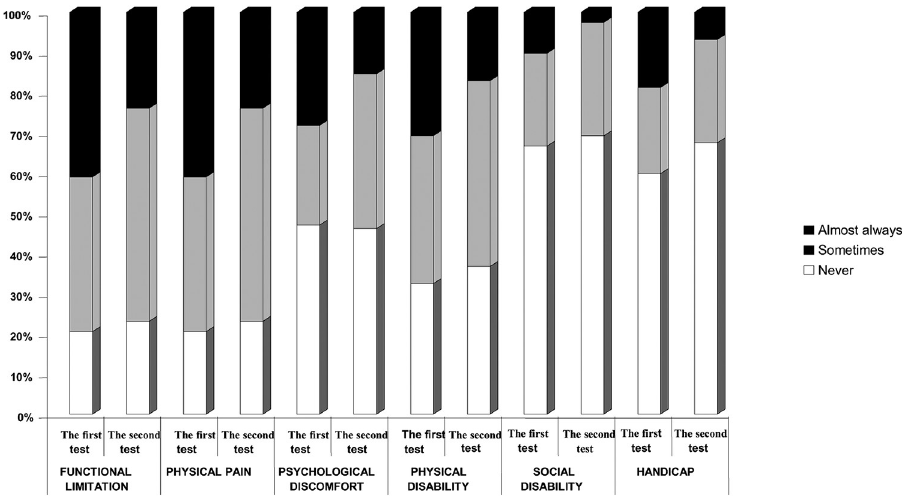
Fig 2. The structure of frequencies of the answers (almost always, sometimes, never) to the single questions before and after corrections and interventions regarding group ohip-edent-B&H indexes.